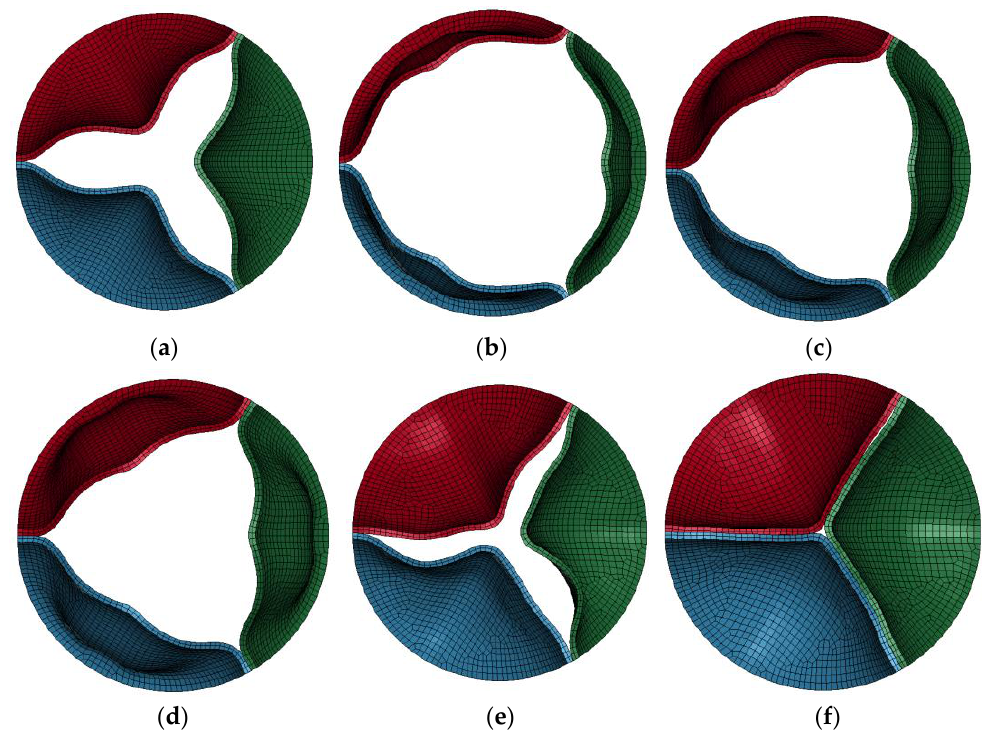
from point (d) to (f). On the contrary, the energy tended to remain almost constant from Figure 12. Deformation behaviors of the leaflets without hysteresis. ( a ) t = 0.06 s, ( b ) t = 0.08 s, ( c ) t = point (b) to (e) where the elastic energy was thought to decrease due to the slight closing 0.2 s, ( d ) t = 0.32 s, ( e ) t = 0.33 s, and ( f ) t = 0.34 s. condition, while the dissipated energy by the hysteresis tended to increase.